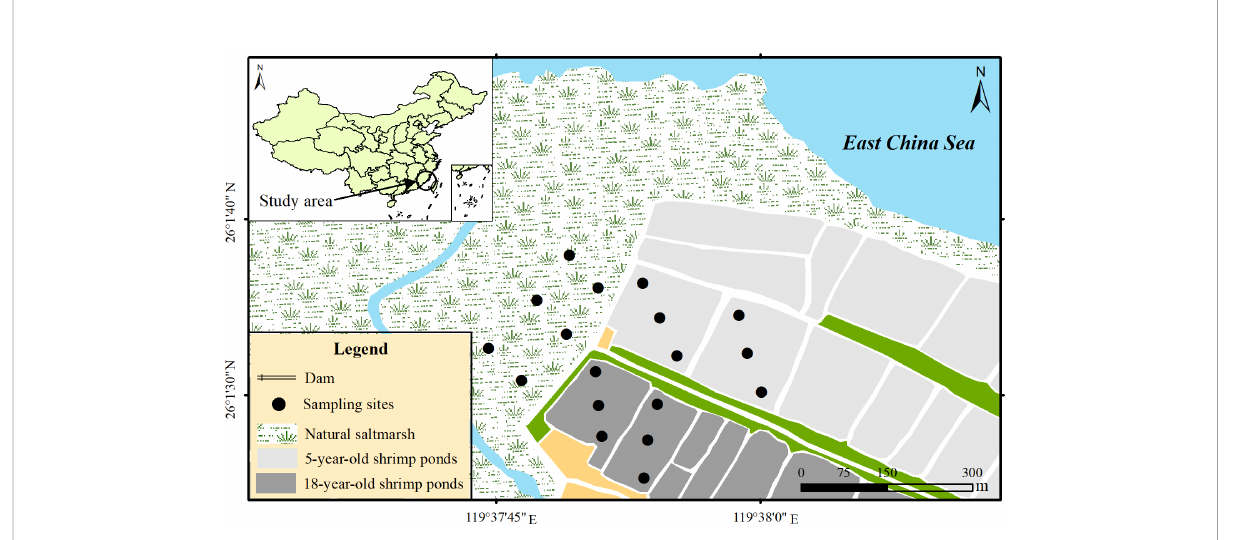
FIGURE 1 Study area and sampling sites (Figure 1 is quoted from our previous research (Gao et al.,